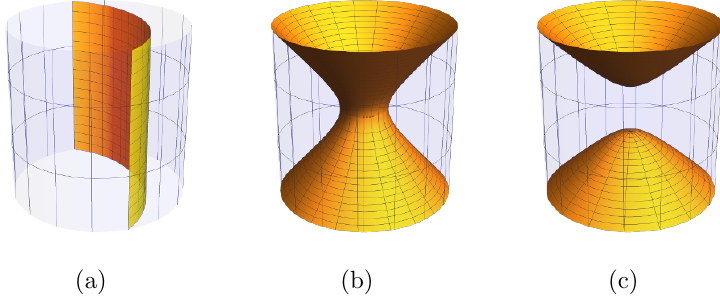
Figure 7. Symmetry-preserving SL(2 ; R ) branes: (a) AdS 2 ; (b) dS 2 ; (c) H 2